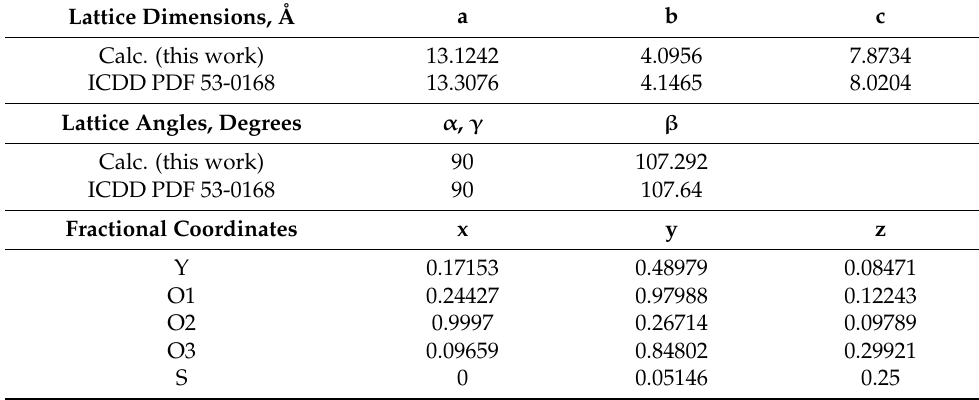
Figure 2. Conventional cell of Y 2 O 2 SO 4 . Table 1. DFT calculated structural parameters for Y 2 O 2 SO 4 in comparison to ICDD PDF 53-0168.